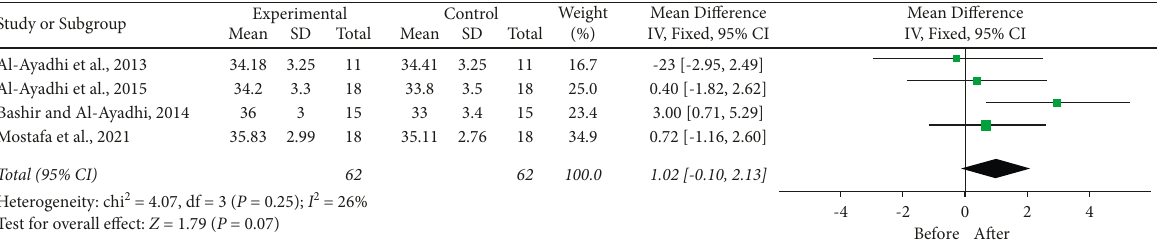
Figure 5: Forest plot of the meta-analysis results showing the effects of treatment on ASD patients consuming cow milk